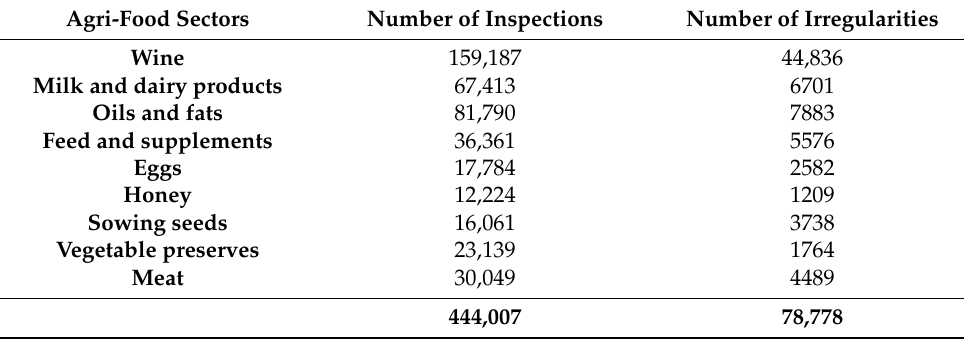
Table 2. Number of irregularities detected in different